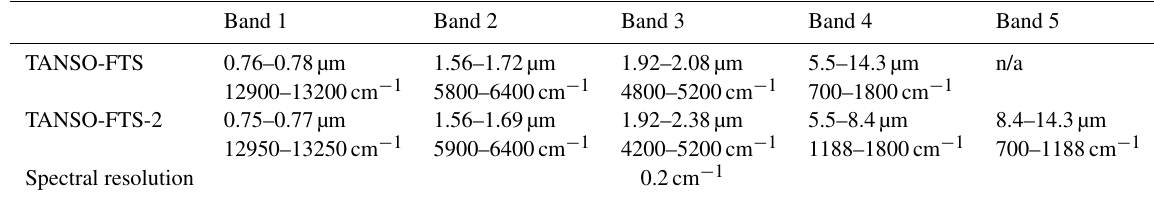
Table 1. Spectral coverage of TANSO-FTS and